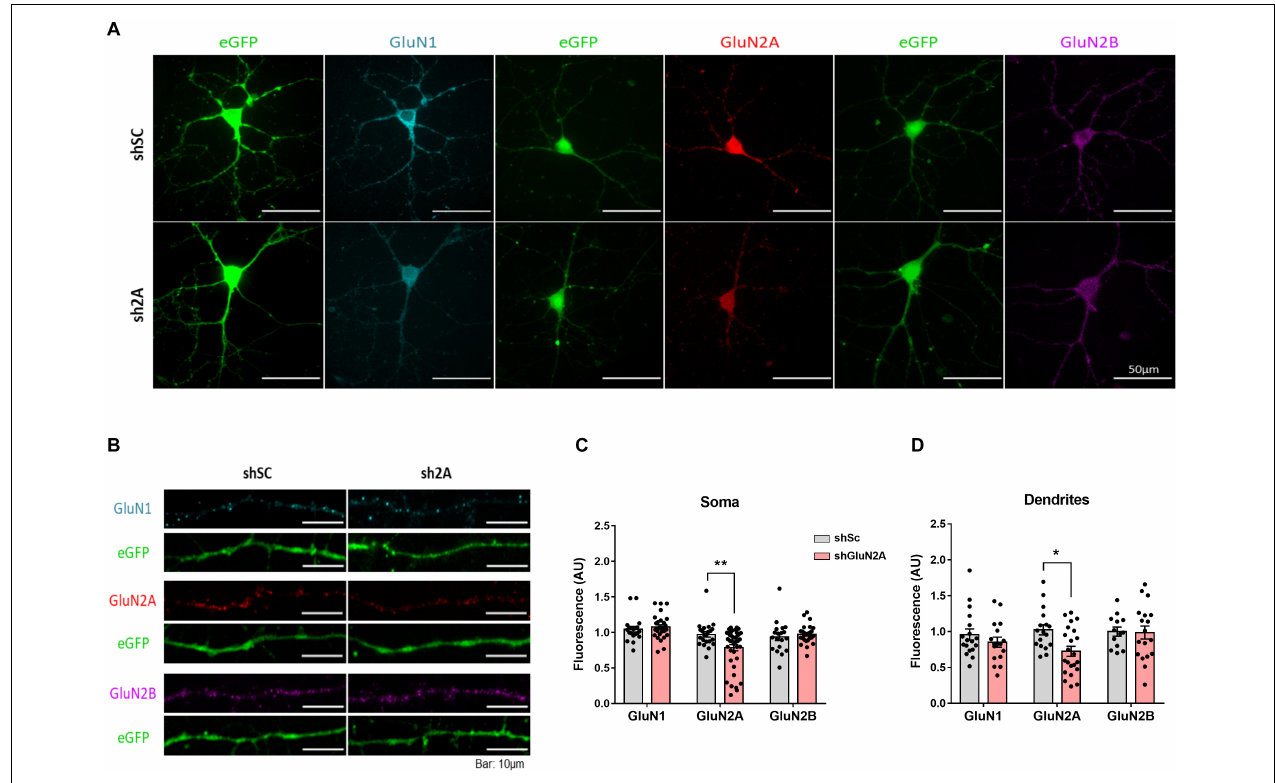
FIGURE 3 | NMDAR cellular distribution in the shGluN2A-transduced cultures. (A) NMDAR subunit immunofluorescence of primary hippocampal neuronal cultures transduced either with AAVe-shsc or AAVe-shGluN2A at 6 DPI. (B) Representative dendrites for GluN1, GluN2A, and GluN2B immunofluorescence. (C) The shGluN2A-transduced cultures showed a significant reduction in GluN2A levels at soma compared with the shsc controls (** p < 0.01, unpaired t test). Nevertheless, GluN1 ( p = 0.5396, unpaired t test) and GluN2B ( p = 0.4897, unpaired t test) levels were similar to controls. (D) There was a significant decrease in GluN2A level ( p = 0.0409, unpaired t test), without differences in GluN1 ( p = 0.3145, unpaired t test) and GluN2B ( p = 0.9079, unpaired t test), at dendrites. Data are represented as mean ± SEM, n = 3 independent cultures.